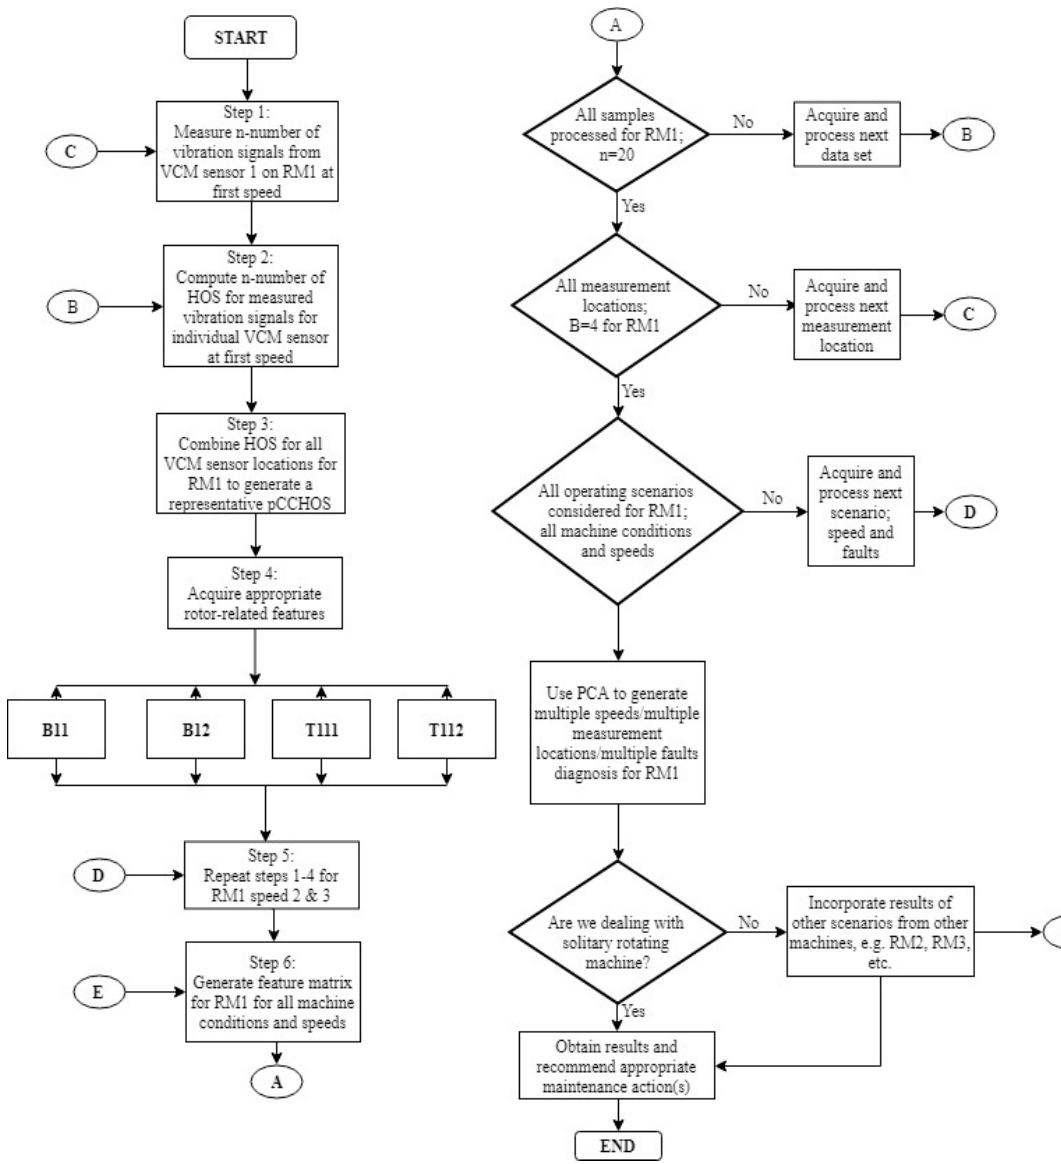
Figure 1. A schematic representation of the integrated data combination approach.